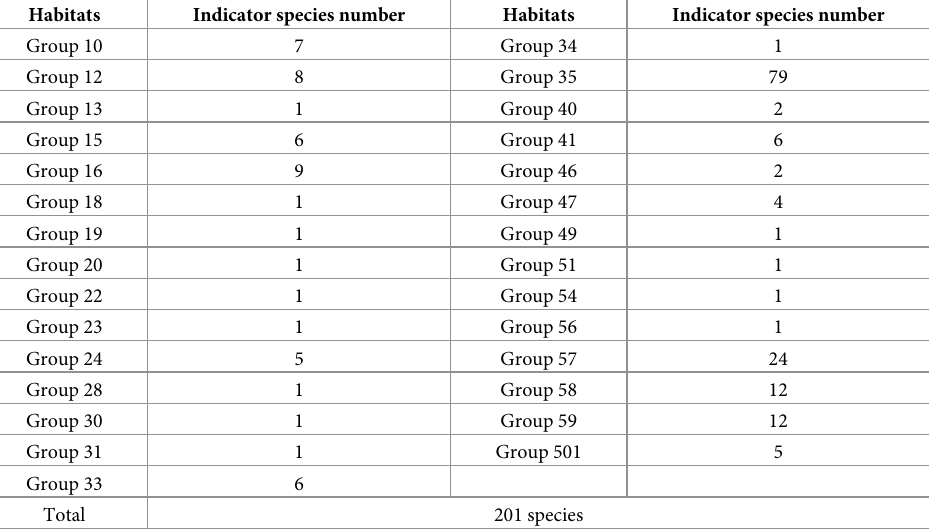
Table 6. Number of indicator species in each habitat. Habitats Indicator species